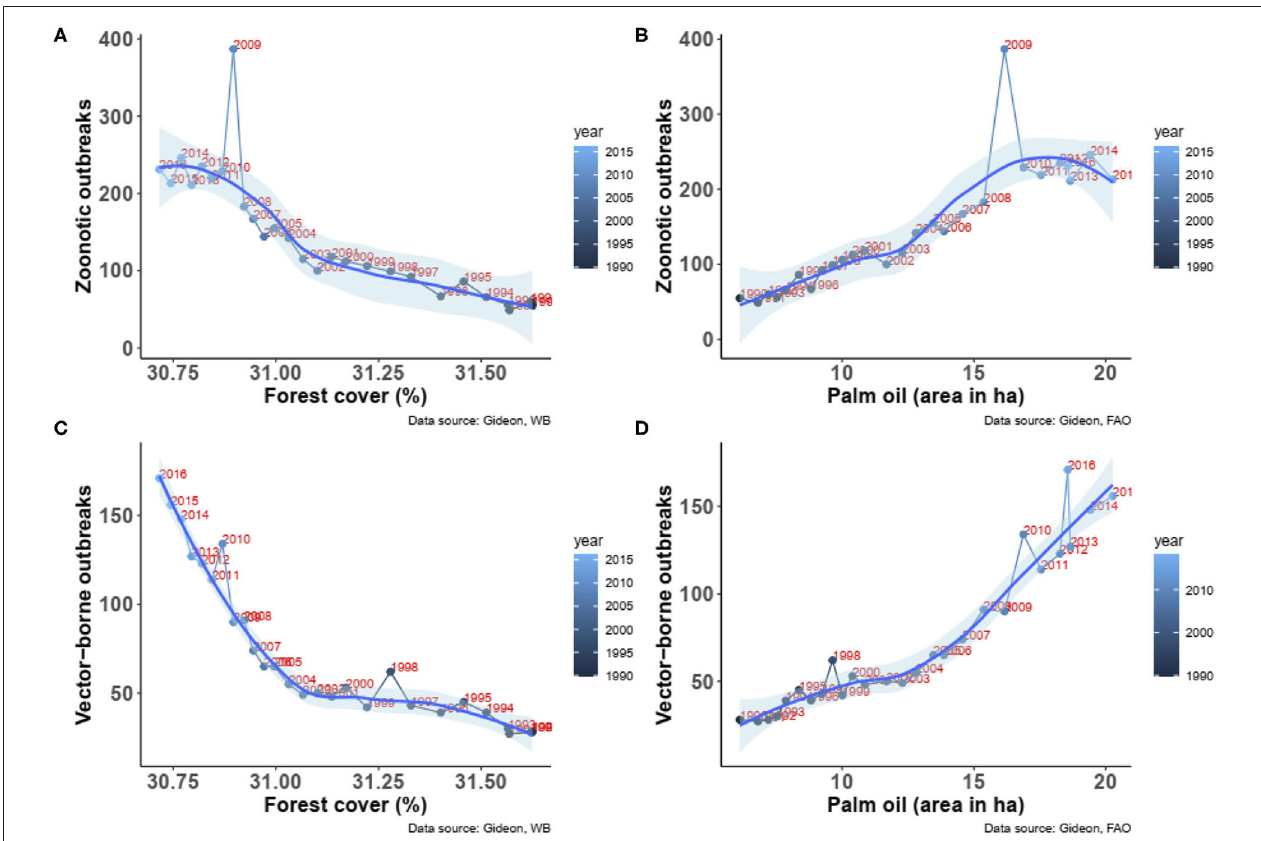
FIGURE 2 | (A) Association between the change in forest cover and the number of outbreaks of zoonotic diseases from 1990 to 2016. (B) Association between the change in forest cover and the number of outbreaks of vector-borne diseases from 1990 to 2016. (C) Association between the change in palm oil areas and the number of outbreaks of zoonotic diseases from 1990 to 2016. (D) Association between the change in palm oil areas and the number of outbreaks of vector-borne diseases from 1990 to 2016. Fitted smooth regressions (in blue) with confidence intervals (in light blue) are shown (data from GIDEON and